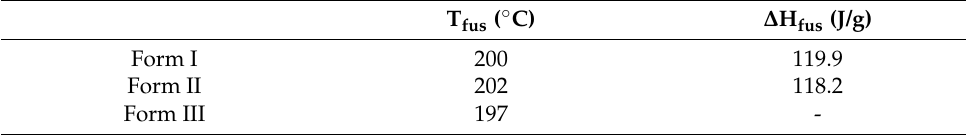
Table 1. Physicochemical data of anhydrous forms of